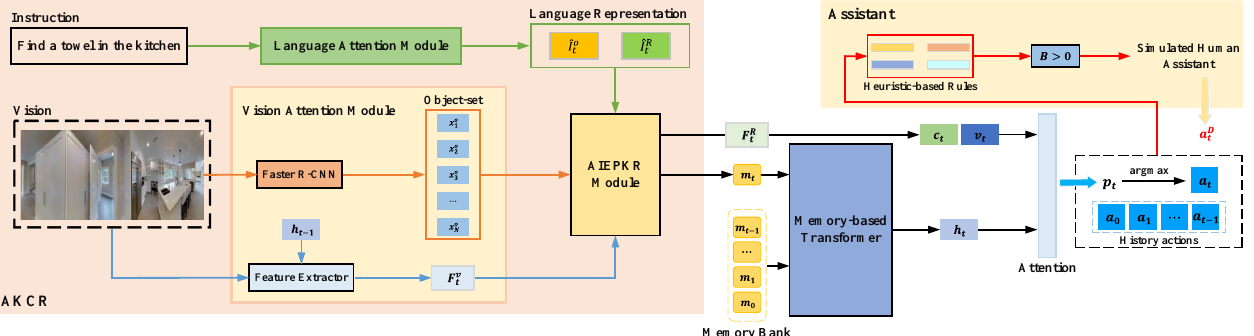
Figure 2. The overall framework of AKCR-AH. The language and vision attention modules extract room/object features from instruction and visual observations, respectively. AIEPKR performs room- and object-entity reasoning to generate the memory token by integrating graph-based commonsense knowledge from ConceptNet. Then, the memory-based Transformer models the memory token sequence for action prediction. The simulated human assistant will provide help when heuristic- based rules are